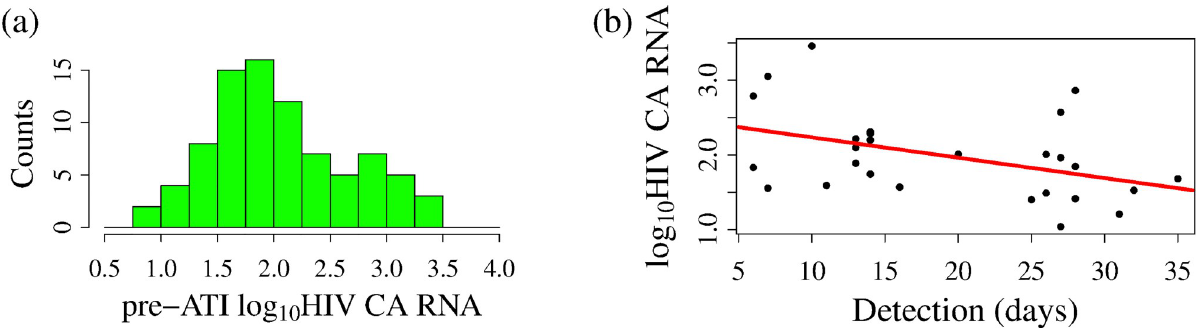
Fig 3. HIV CA-RNA and HIV viral rebound. (a) Histogram showing pre-ATI log 10 (HIV CA RNA (per 10 6 CD4+ cells)) across study participants. (b) Correlation between pre-ATI log 10 (HIV CA-RNA (per 10 6 CD4+ cells)) and time to viral rebound in non-NNRTI study participants (p-value 0.0260). Data shown only for study participants who showed viral loads less than 10000 HIV RNA/mL at first detection.